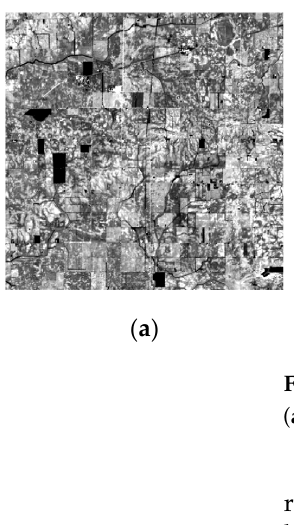
Table 4. Fisher’s linear discriminant analysis, including the within-class scatter metric ( 𝑆 (cid:3024) ), be- tween-class scatter metric ( 𝑆 (cid:3003) ), 𝑆 (cid:3003) /𝑆 (cid:3024) , and information entropy of the classification results of GIC for the RGB composites of the Landsat 8 and aerial images.